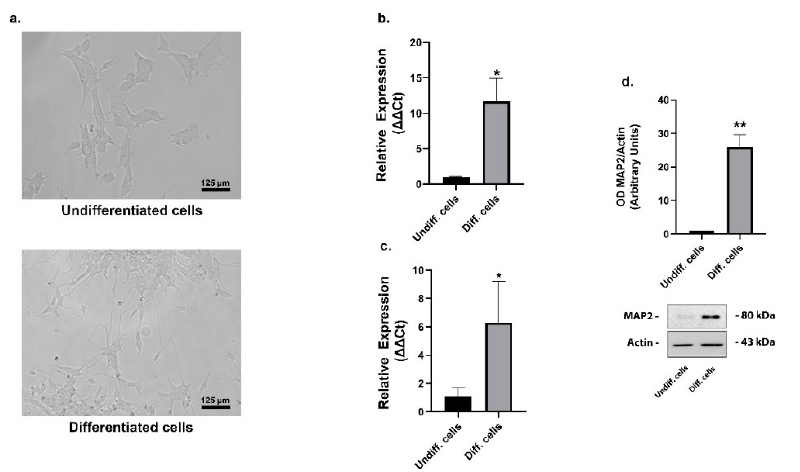
Figure 1. SHSY5Y cells differentiation. Representative phase contrast images of cellular morphology of SHSY5Y cells before (top left) and after (bottom left) the differentiation protocol. Morphology of differentiated cells showed prominent neurites outgrowth ( a ). Relative expression of the neuronal markers TH mRNA ( b ) and synaptophysin ( c ) significantly increased in differentiated cells (means ± SD of three independent experiments). Representative immunoblots of the neuronal marker MAP2 ( d ) in undifferentiated and differentiated cells. Densitometric analysis of bands represented means ± SD of three independent experiments (right). β -actin was used as loading control ( c ). The results were presented as means ± standard deviation of three independent experiments; values for differentiated cells were compared to undifferentiated cells by one-way ANOVA following Tukey test * p < 0.0332 ** p < 0.0021.